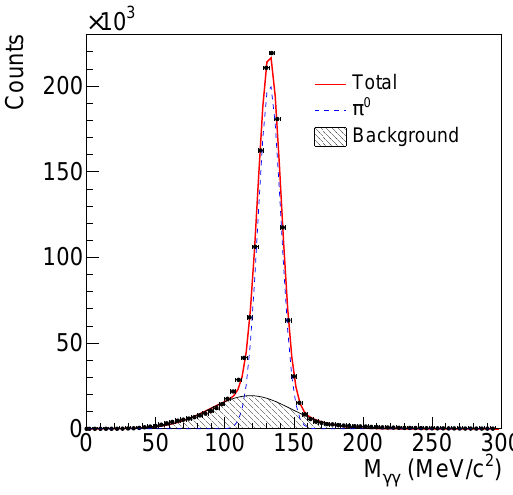
Figure 2: Reconstructed two photon invariant mass distribution of Type-I event in > 0.25 and 0.0 < p < 1.0 GeV / c x F T